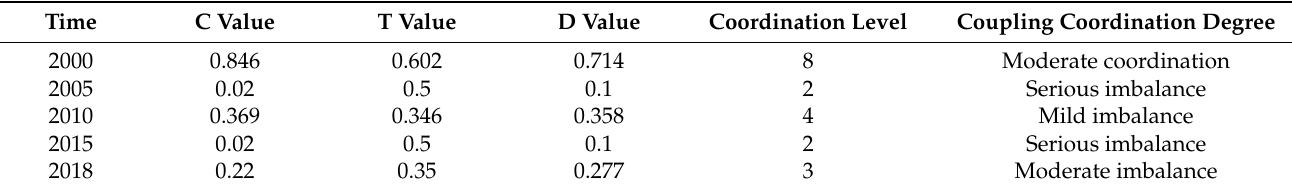
Table 6. The coupling coordination level of ecosystem changes in the 9 intensities zone from 2000 to 2018. Time C Value T